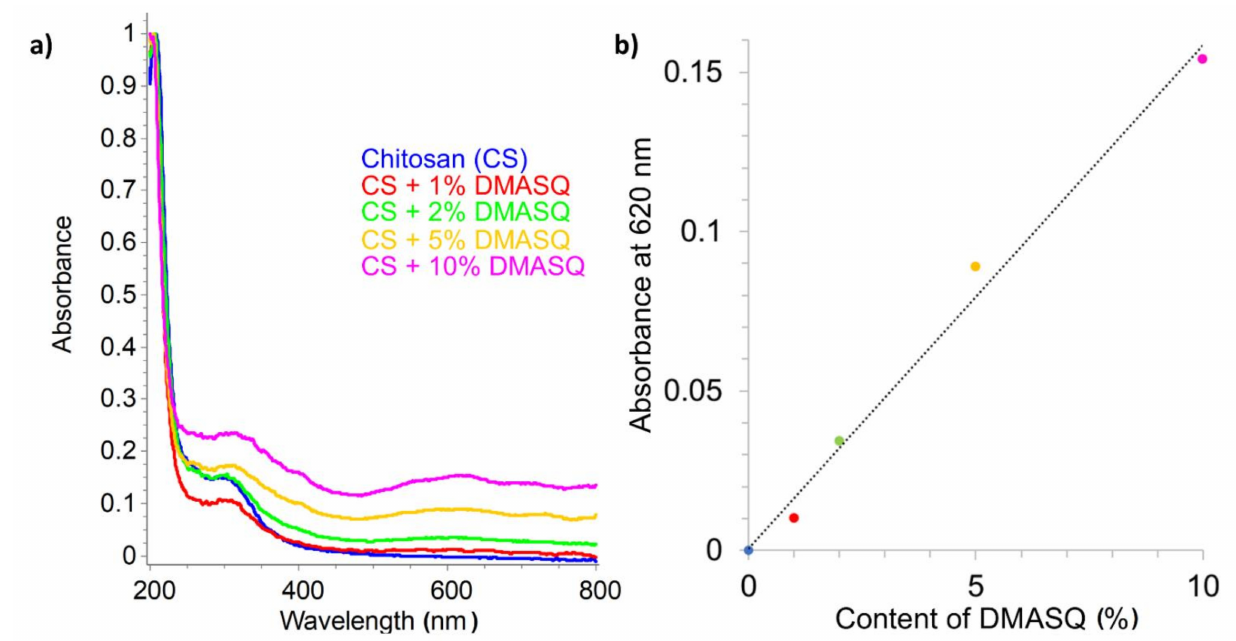
Figure 7. Diffuse reflectance spectra of chitosan films containing 1–10% DMASQ normalized at 210 nm ( a ) and the dependence of absorbance at 620 nm on the percentage of dye in the CS matrix ( b